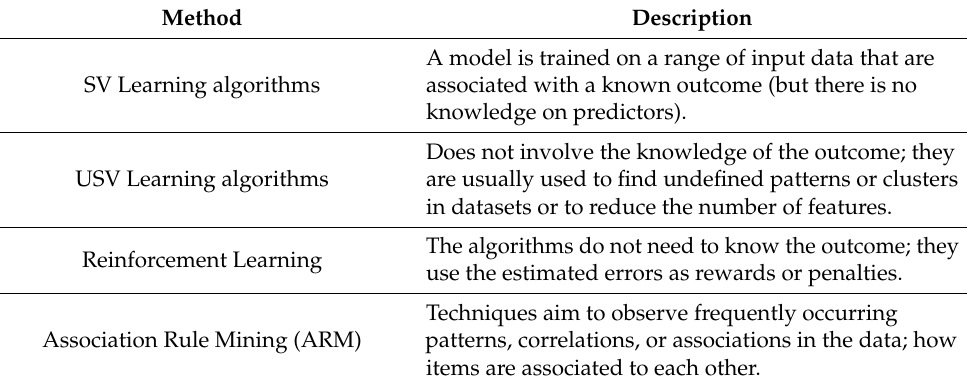
Table 2. The list of methods in Machine Learning/Big Data-AI research approach